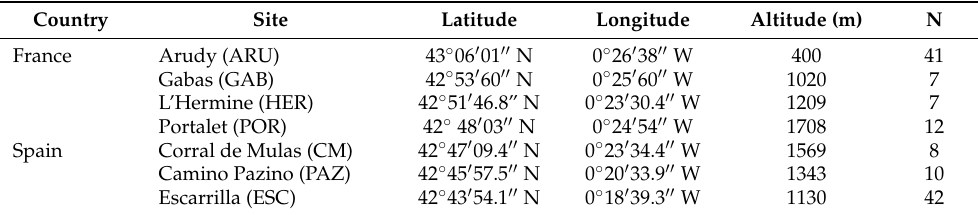
Table 1. Locations sampled at the Portalet contact zone between the CPP and CPE subspecies of the grasshopper Chorthippus parallelus in the Pyrenees, including two purebred samples at Arudy for CPP and Escarrilla for CPE. N = Number of